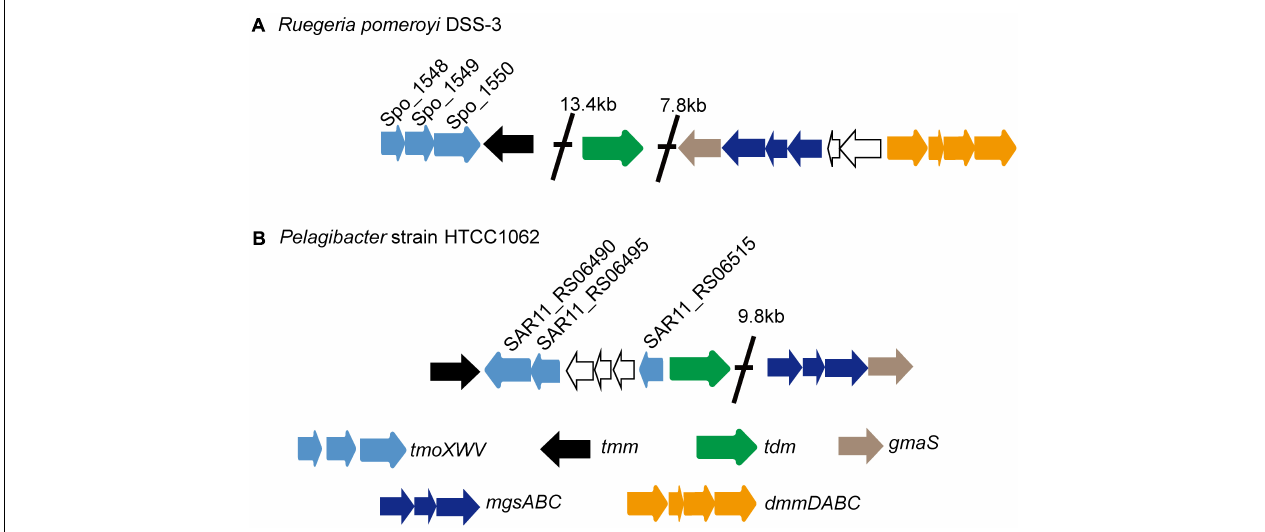
FIGURE 1 | The gene clusters involved in TMAO transport and metabolism in the MRC bacterium R. pomeroyi DSS-3 (A) and in the SAR11 bacterium HTCC1062 (B) . Tdm, trimethylamine N-oxide demethylase; Tmm, trimethylamine monooxygenase; TmoXVW, ATP-dependent TMAO transporter; DmmDABC, DMA monooxygenase; MgsABC, N-methylglutamate synthase; GmaS, γ -glutamylmethylamide